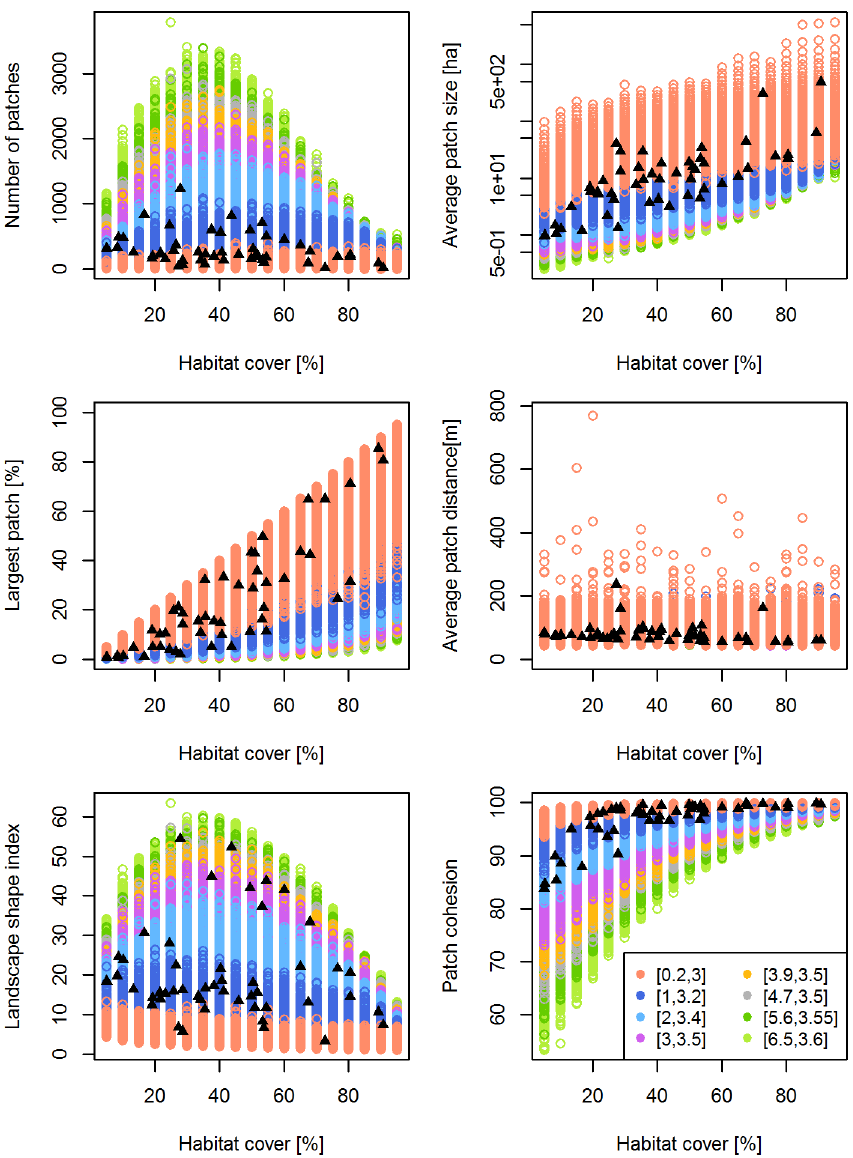
Figure 2. Attributes of the landscapes generated by G-RaFFe . Generated landscape parameters are illustrated in colored circles, and compared to 50 real landscape maps (full triangles) according to six explored landscape attributes, each against habitat cover: a) Number of patches, b) Average patch size, c) Largest patch index, d) Average distance between patches, e) Landscape Shape Index, and (f) Patch cohesion. The colors represent the effect of the number of roads, expressed by the combination of parameters ( a,b ) that determines the relation between habitat cover and the number of roads. Overlaps between parameter outputs cannot be seen due to color dominance.